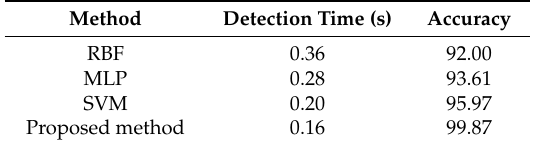
Table 10. Comparison of detection time for different